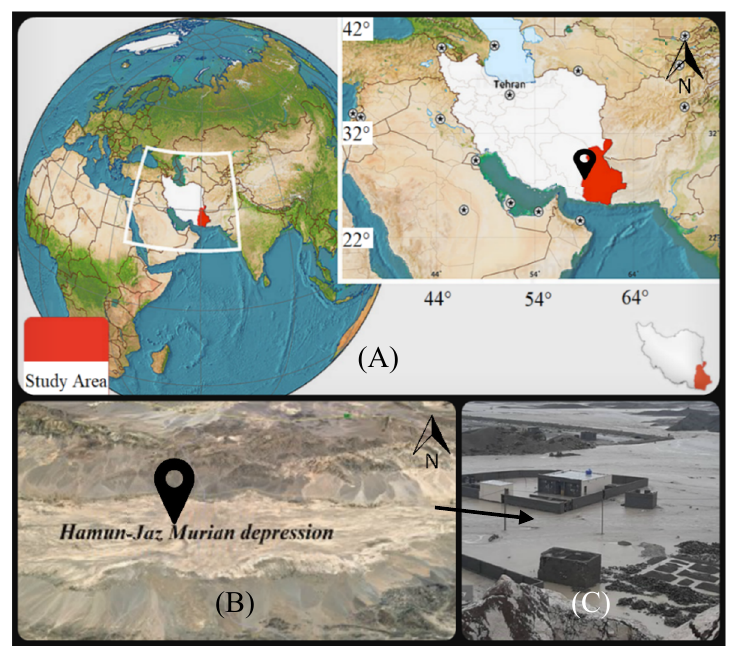
Figure 1. ( A ) The red region shows the location of the Sistan and Baluchestan province in the southeast of Iran, which is our study area. ( B ) The Hamun Jaz-Murian depression, which is located between the Kerman and Sistan and Baluchestan provinces. ( C ) IranShahr, one of the flooded cities in the study area. Sistan and Baluchestan is one of the warmest regions in Iran, with a desert climate and an average daily temperature of 29 degrees centigrade. For several months of the year, it is warm at 40 degrees centigrade. Figure 2 illustrates the average precipitation per day over 20 years. As can be seen, 0.40 mm / day rainfall is normal during January in the province, but between 10 January and 12